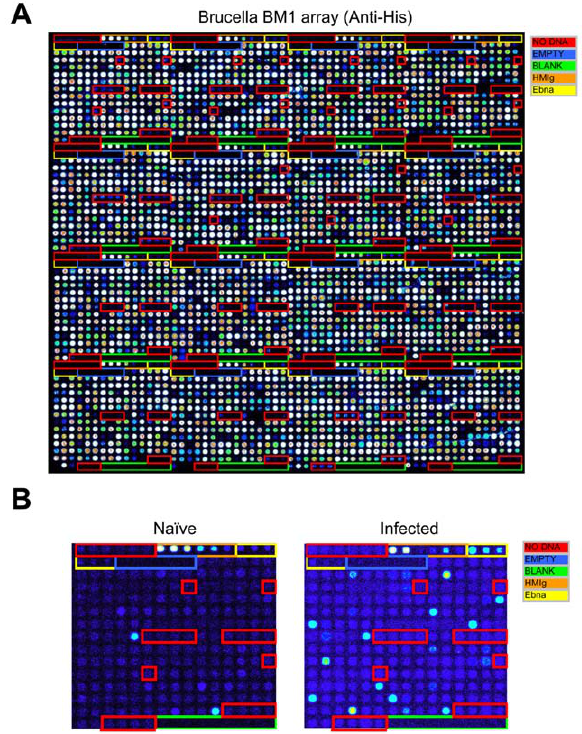
Figure 1. Construction of a B. melitensis Protein Microarray. Arrays were printed containing 1406 B. melitensis proteins, positive and negative control spots. Proteins were printed in duplicates. Each array contains positive control spots printed from 6 serial dilutions of human and mouse IgG, 6 serial dilutions of EBNA1 protein, and ‘‘No DNA’’ negative control spots. (A) The array was probed with anti-His antibody as described in Materials and Methods, to confirm the expression and printing of over 95% proteins. (B) Comparison of arrays probed with Peruvian naı¨ve serum and Culture positive serum. The arrays were read in a laser confocal scanner, analyzed, and the data normalized as described in Materials and Methods. The signal intensity of each antigen is represented by rainbow palette of blue, green, red and white by increasing signal intensity.